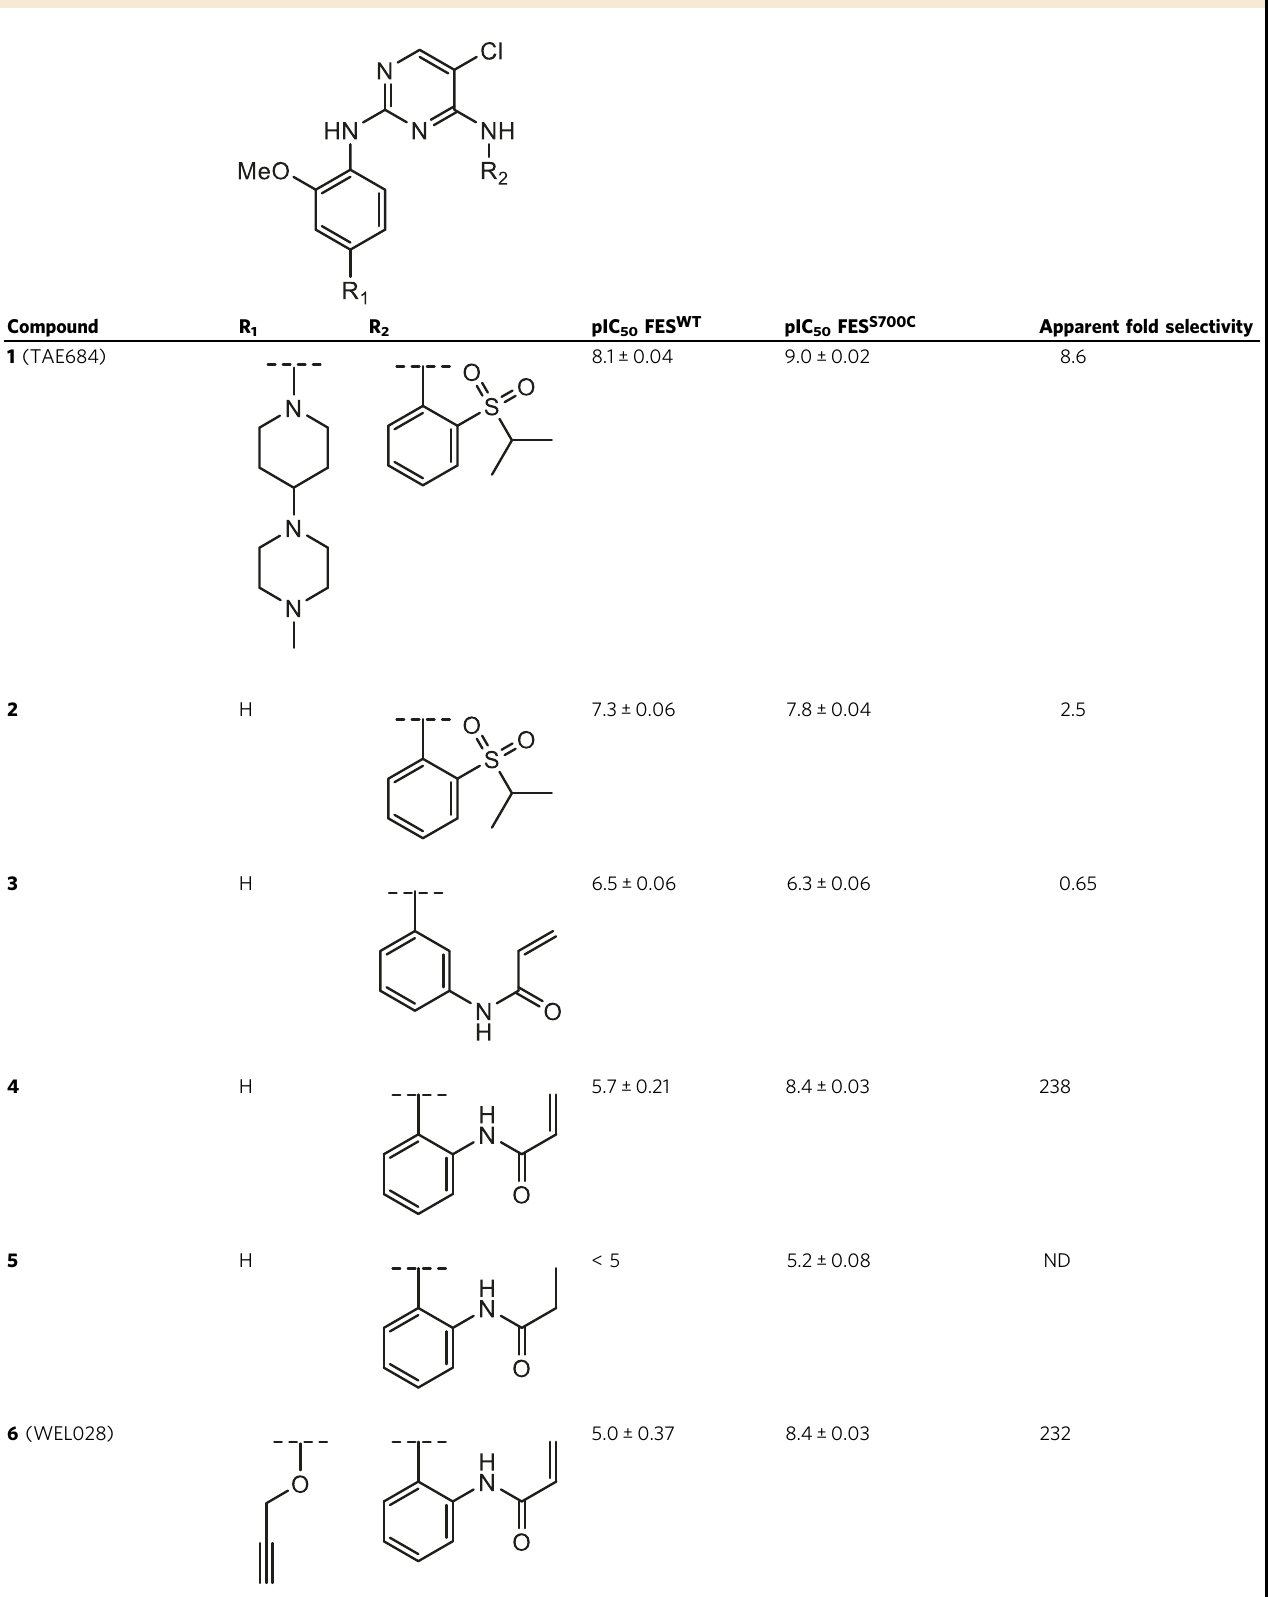
Table 1 Inhibitory potency of synthesized TAE684 derivatives against FES WT and FES S700C